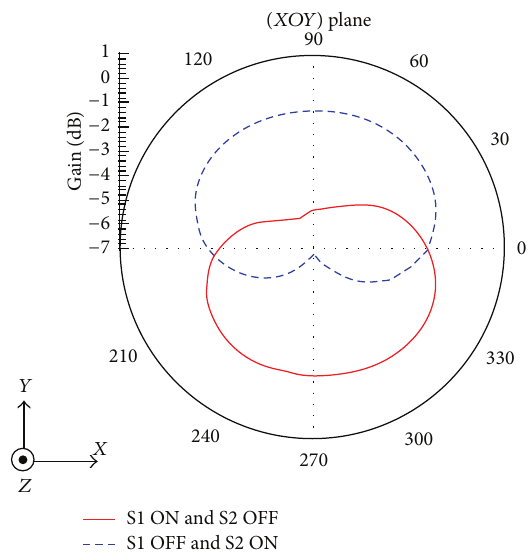
Figure 16: Measured 2D radiation patterns of the prototype two NFRP elements reconfigurable at 𝑓 𝑅 = 1.180 GHz: State 1 and State